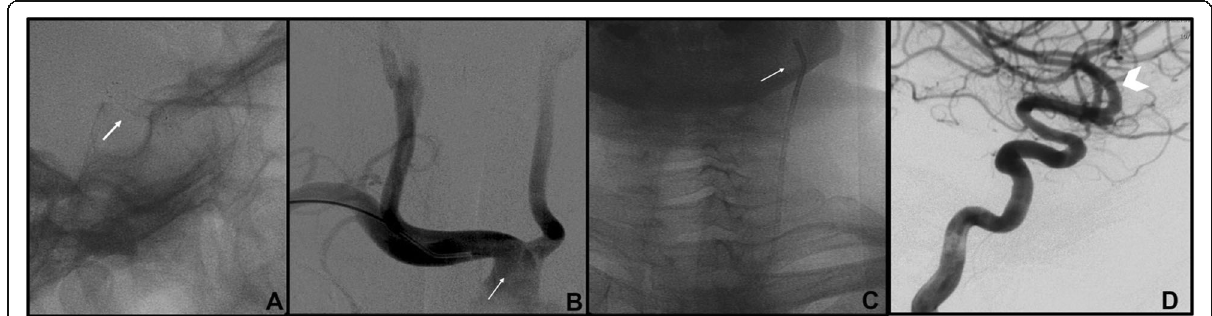
Fig. 3 Follow-up cerebral DSA for left para-ophtalmic ICA aneurysm treated with a FD stent (arrow in a ) in a 47-year-old woman. Presence of